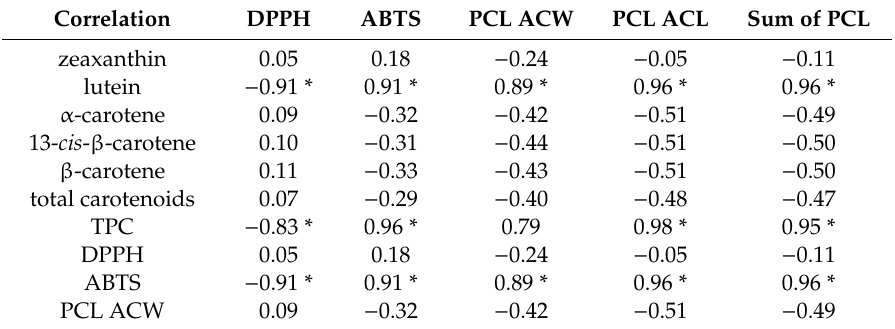
Table 3. Correlation coe ffi cients (r) calculated for the relationships between carotenoids, total phenolic content and antioxidant activity assays (r marked by * are statistically significant at p <